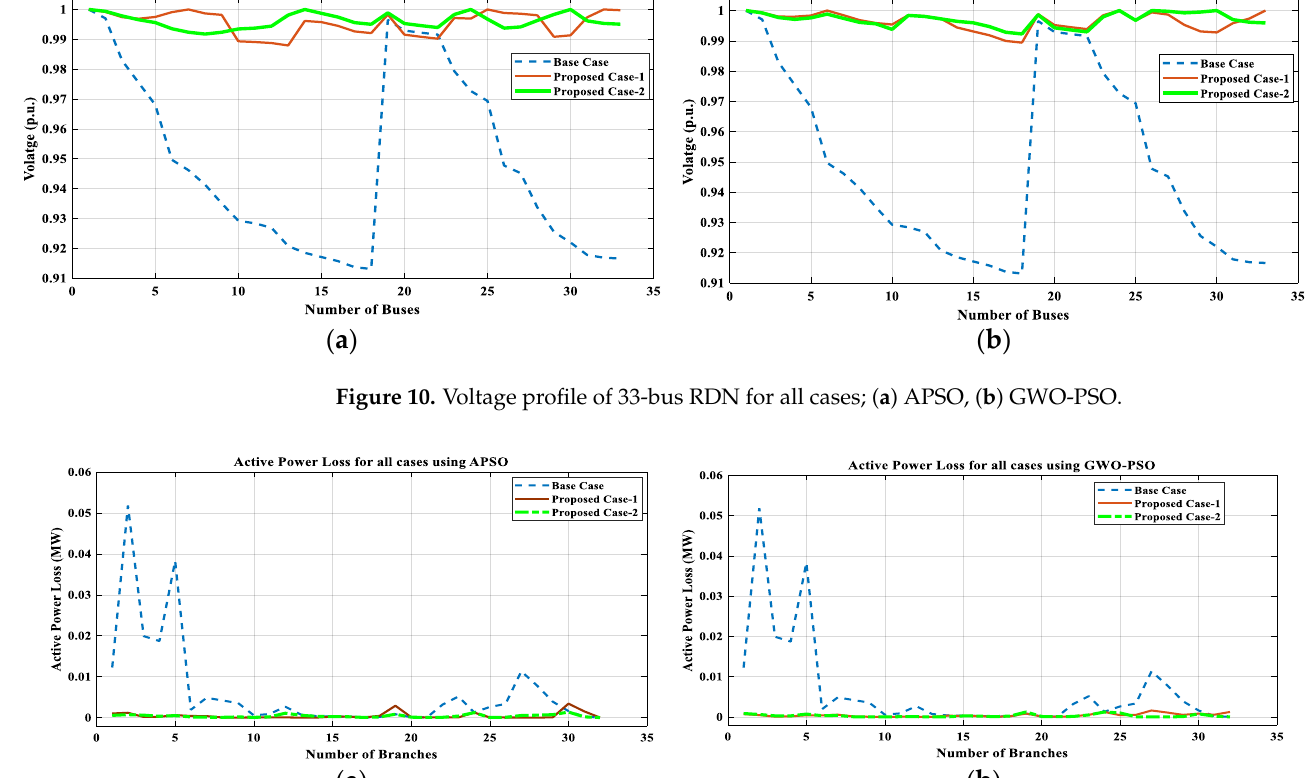
Figure 12. Reactive power loss for all cases of 33-bus RDN; ( a ) APSO, ( b ) GWO-PSO.